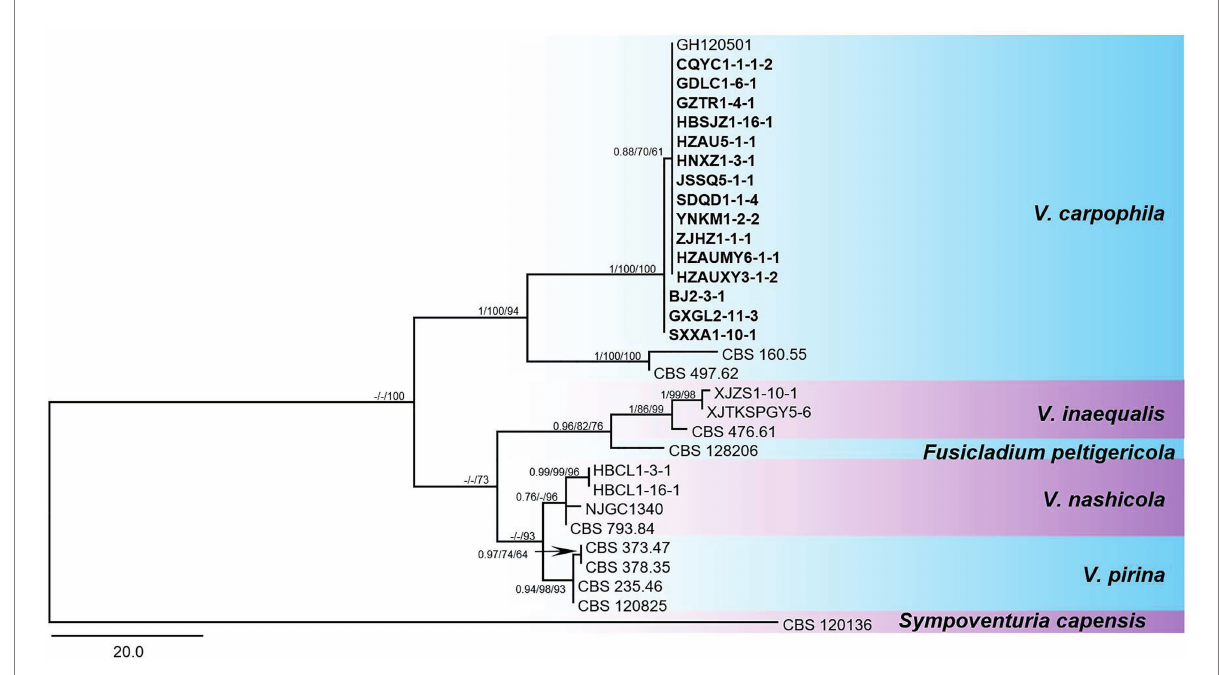
FIGURE 4 Phylogenetic tree in the Venturia species inferred from combined alignment with a two-locus dataset ( LSU + ITS). The maximum parsimony (MP) analysis was shown for the phylogenetic relationships of species among Venturia spp. and closely related species. The tree was rooted to Sympoventuria capensis (CBS 120136). The Bayesian posterior probabilities values (BIPP) > 0.70, maximum likelihood and maximum parsimony bootstrap values (MLBS and MPBS) > 50% were shown at the branch nodes (BIPP/MLBS/MPBS). Scale bar estimated substitutions per site with 20. The isolates used in this study were displayed in bold